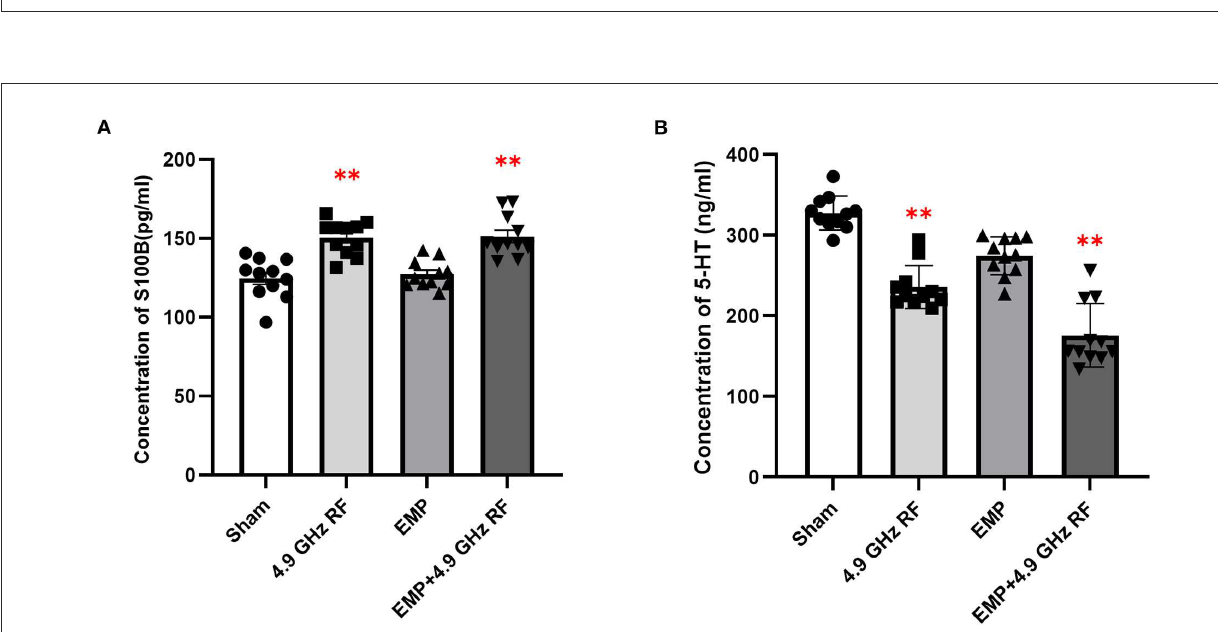
FrontiersinPublicHealth